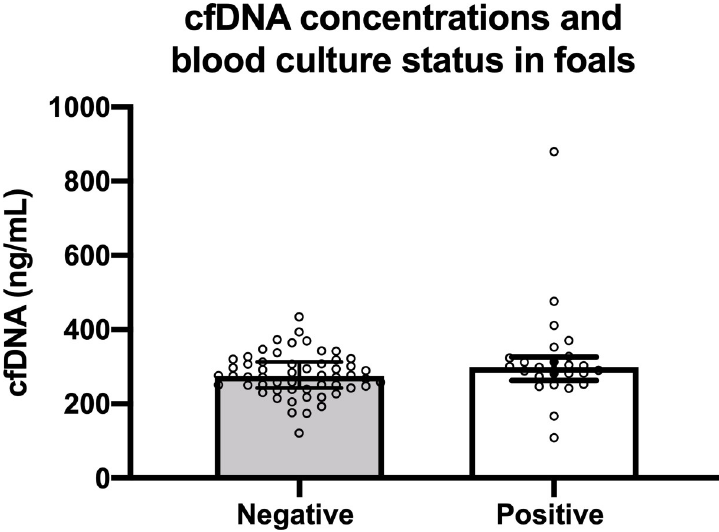
Fig 3. Plasma cell-free DNA (cfDNA) concentrations in 80 hospitalized neonatal foals with positive blood culture (n = 24) and negative blood culture (n = 56). Symbols represent values for individual foals with median and interquartile range error bars (P = 0.07).